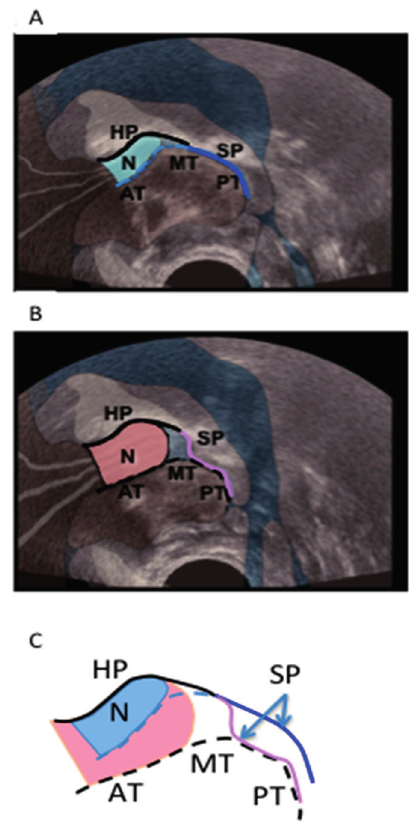
Figure 1. Submental ultrasound image of nipple in infant’s mouth during breastfeeding at, ( A) the tongue up position, and ( B) the tongue down position. ( C) is a diagrammatic representation of the nipple shape and tongue position at tongue up (blue) and tongue down (pink); HP, hard palate; SP, soft palate; N, nipple; AT, anterior tongue; MT, mid-tongue; PT, posterior